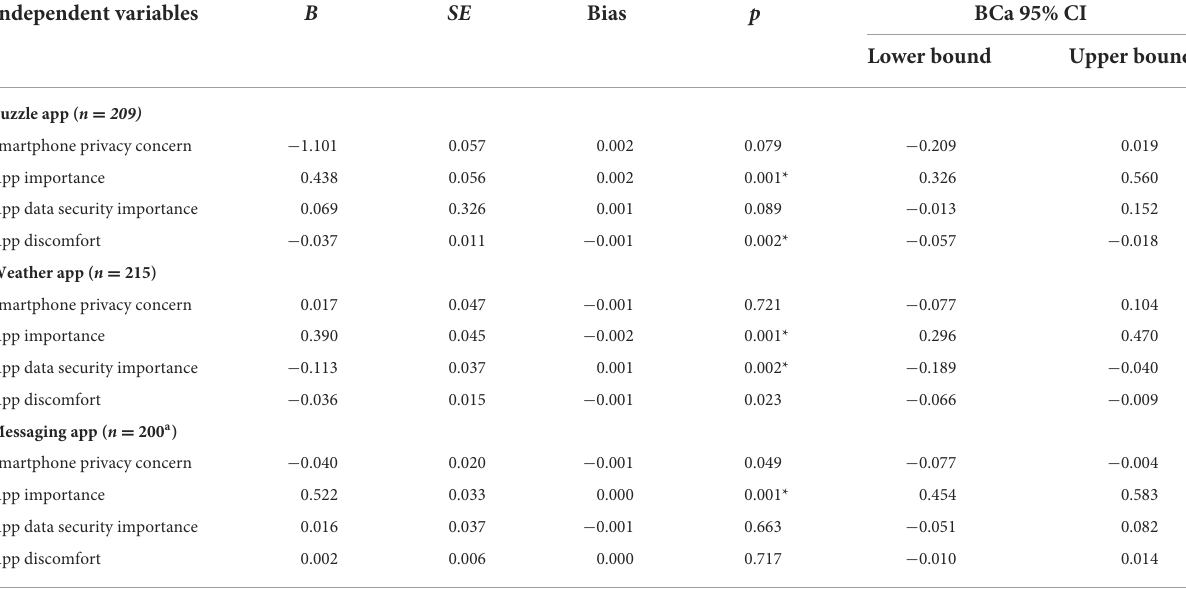
TABLE 2 Results of bootstrapped multiple regression analysis with intention of installing the app as dependent variable, study 1. Independent